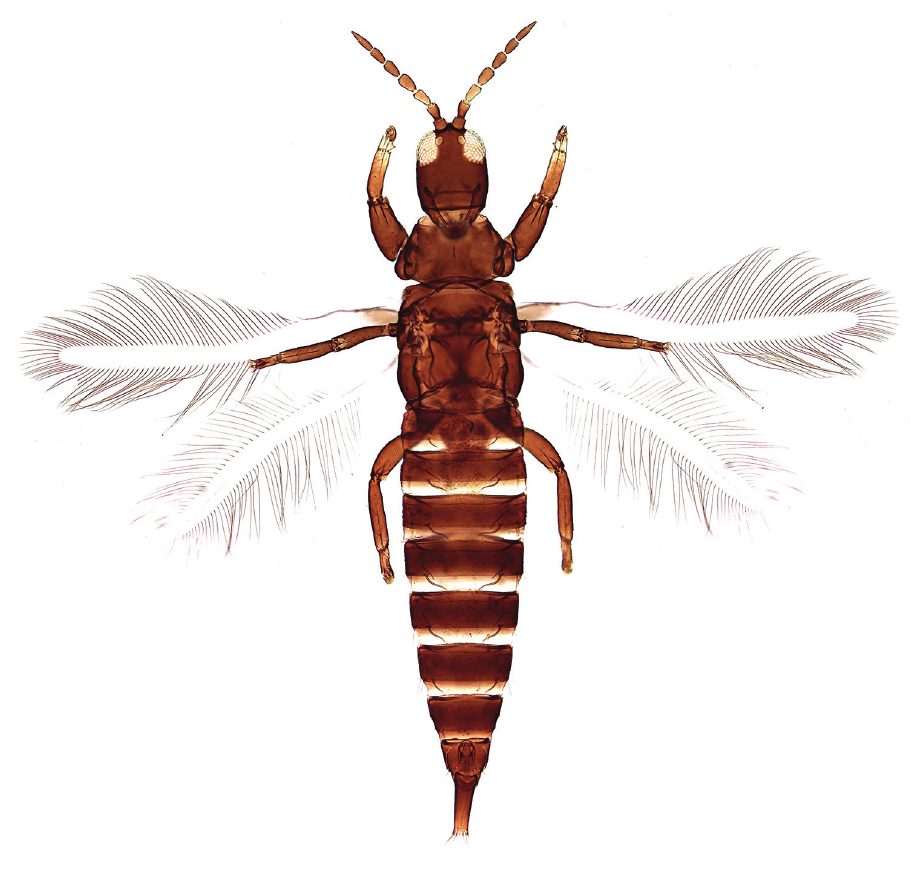
Figures 2. Haplothrips shivendraii sp. n.: